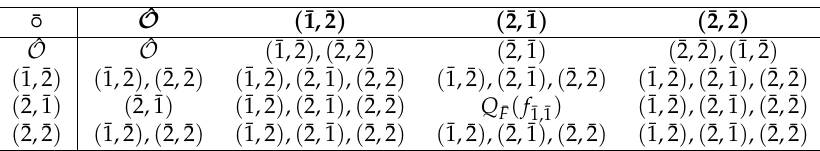
Table 4. Conic H v -group,